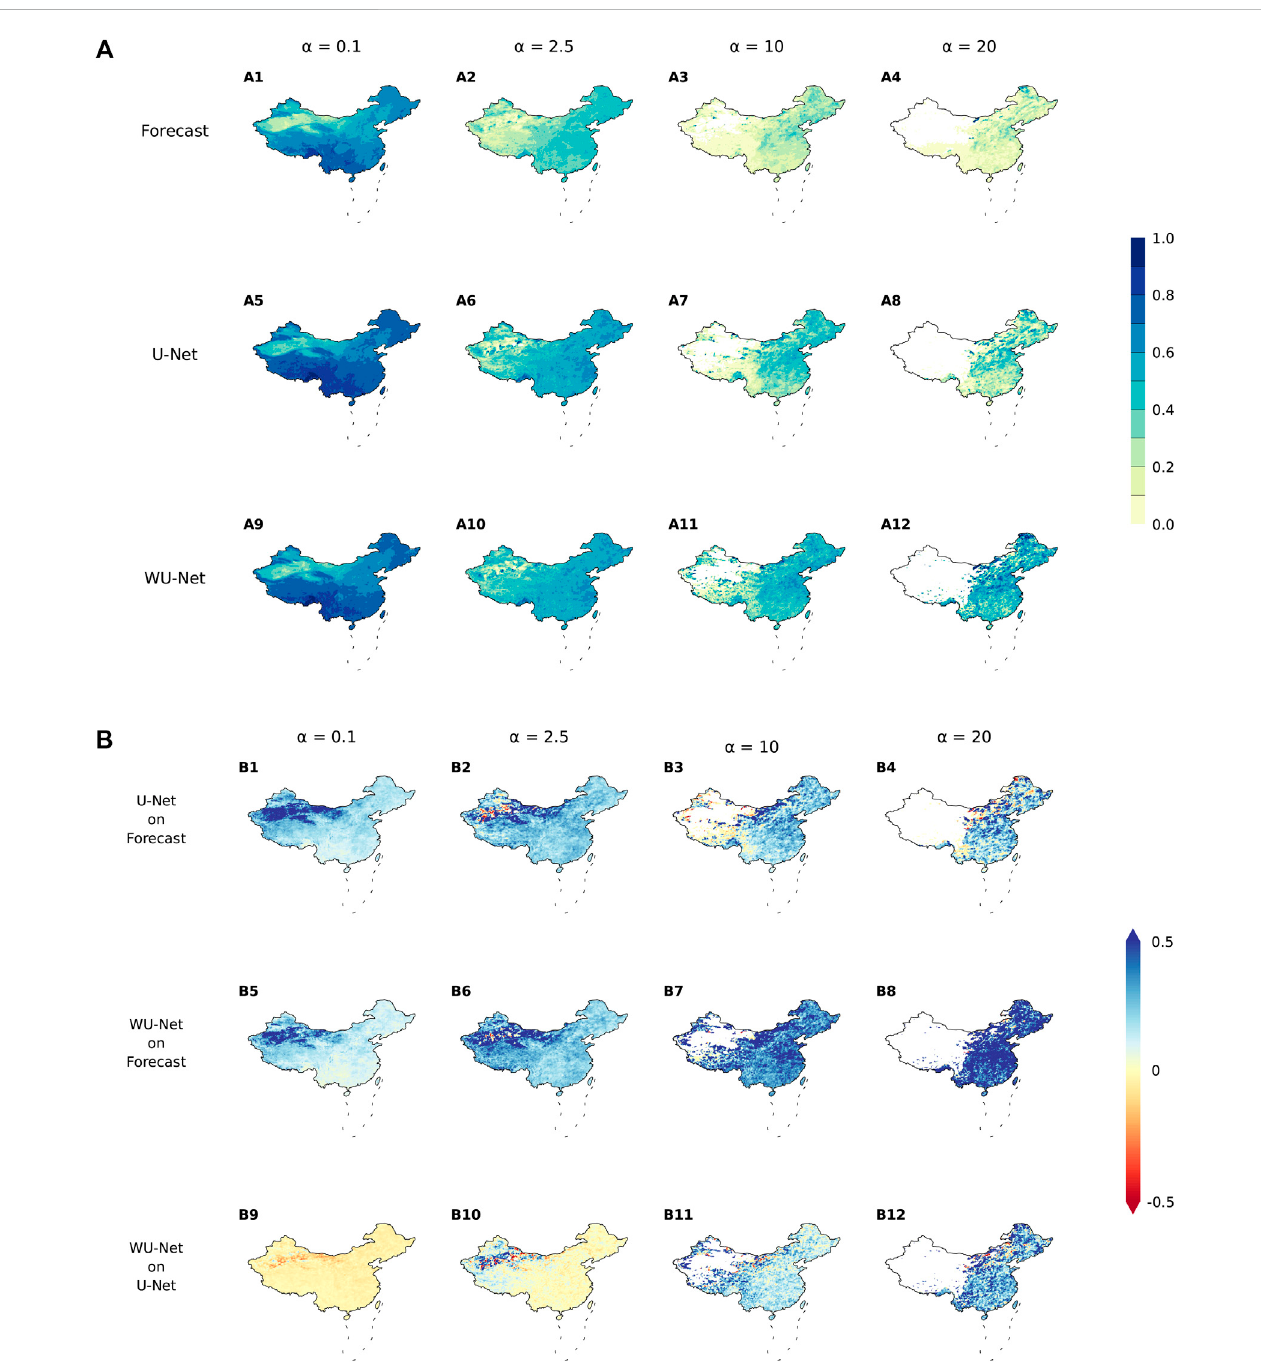
FIGURE 8 (A) TS distribution, from top to bottom: the ECMWF-IFS, U-Net and WU-Net, and from left to right: thresholds 0.1, 2.5, 10, and 20 mm. (B) Spatial improvement of TS as percentage, from top to bottom: U-Net on the ECMWF-IFS, WU-Net on the ECMWF-IFS and WU-Net on U-Net, and from left to right: thresholds 0.1, 2.5, 10, and 20 mm. The blank areas derive from the denominator of zero when calculating the TS, due to all the samples on the grids are True Negative (to see in Table 3). The areas out of China have been masked